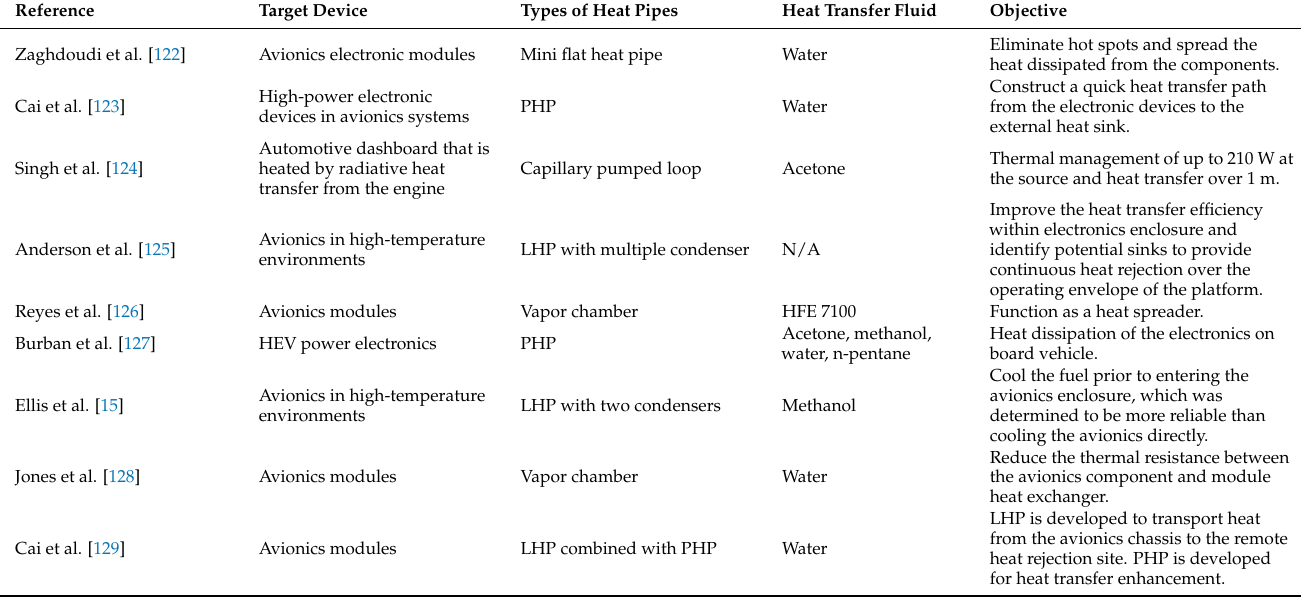
Table 7. Summary of heat pipes used for thermal management of electronics on board automobiles and